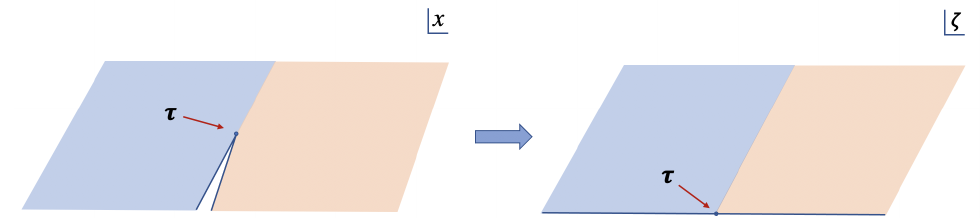
Figure 9. A Schwarz-Christoffel transformation maps the open string joining/splitting interaction to the upper half plane.